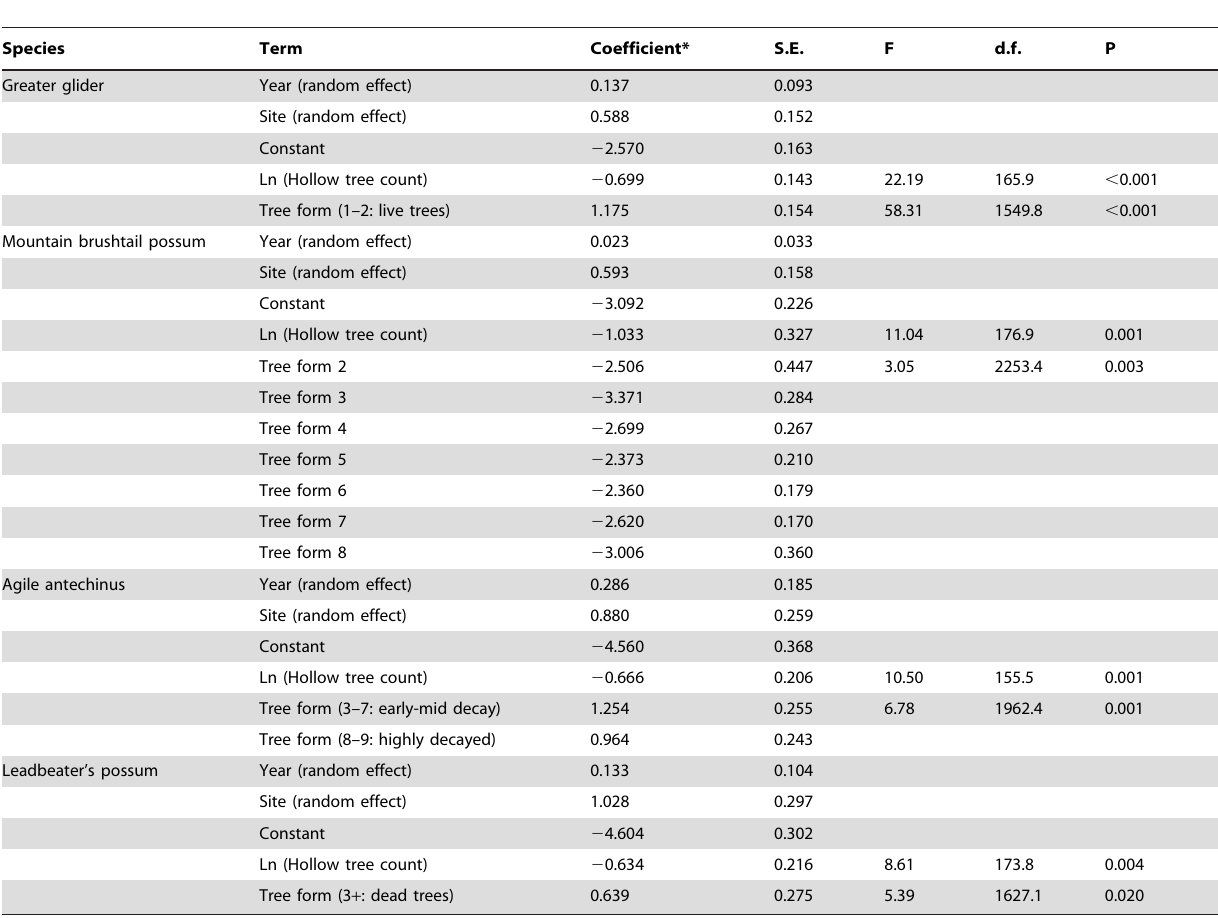
Table 2. Binomial generalised linear mixed models of the probability of a hollow tree being occupied by four species of arboreal